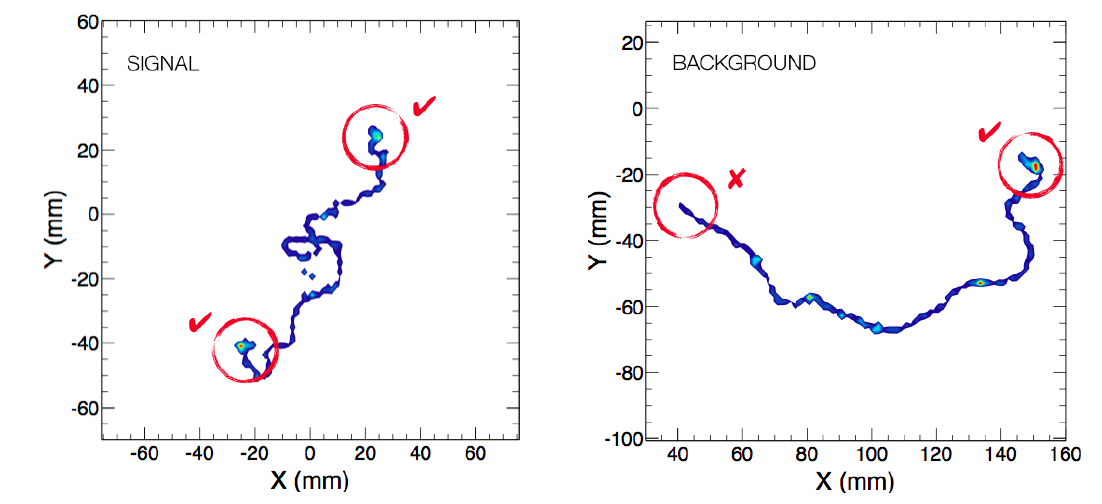
Figure 1 . A (cid:12)(cid:12) 0 (cid:23) event (left) and a single electron background event from a 2.447 MeV 214 Bi gamma (right) in Monte Carlo simulation. Both events are simulated in gaseous xenon at 15 bar gas